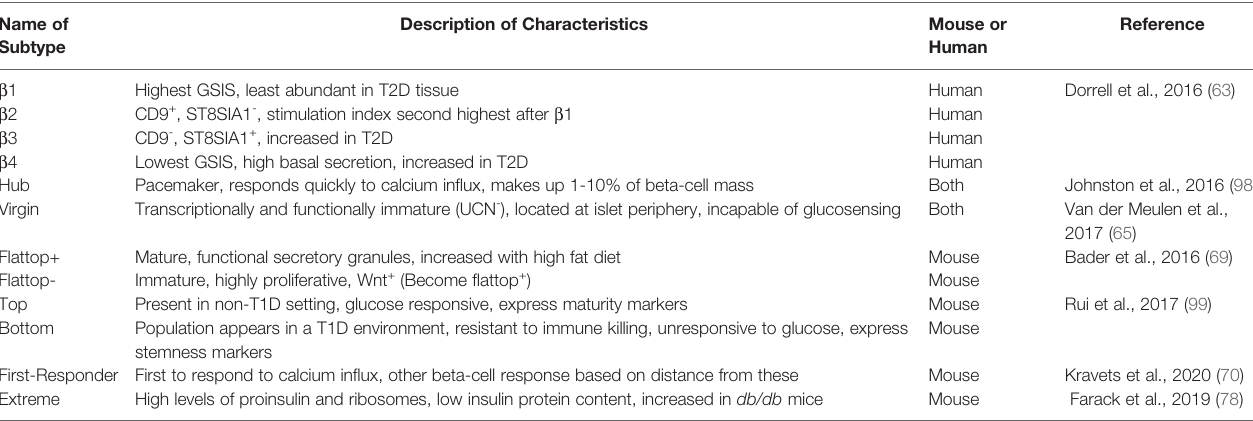
TABLE 1 | Selected pancreatic beta-cell subtypes. Heterogeneity in beta-cell response has led to the identi fi cation of beta-cell subtypes. These subtypes may vary in spatial location within the islet, speed of response to a stimulus, and secretory capacity. The names of beta-cell subtypes, description of characteristics, and whether they were identi fi ed in mouse or human pancreata are de fi ned